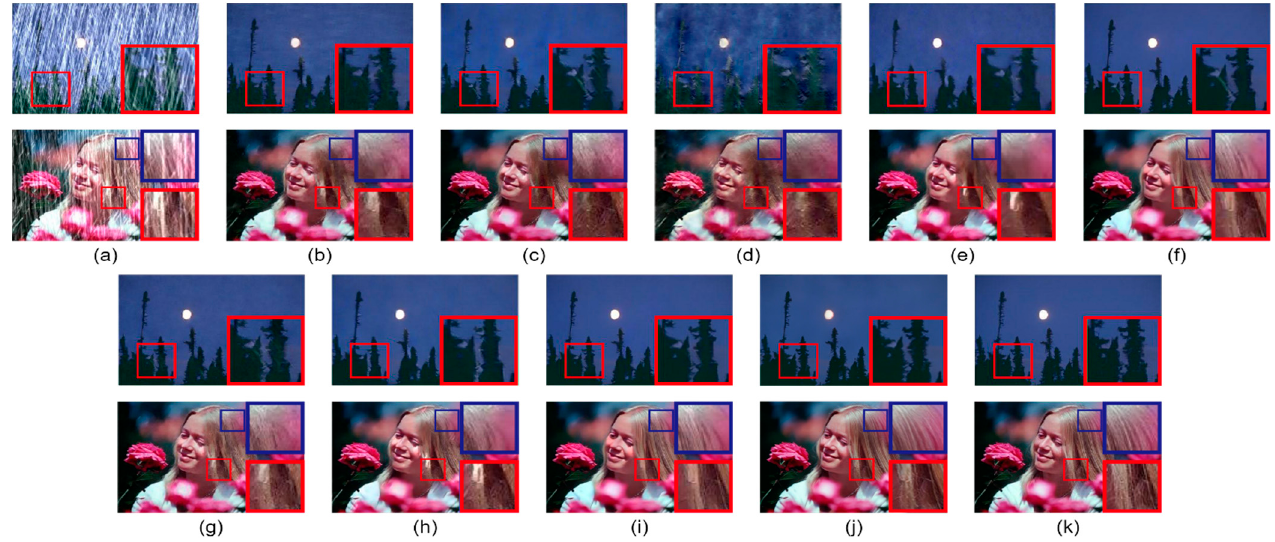
Figure 7. Deraining task performance of the proposed MARCAFNet and state-of-the-art methods when using the Rain100H dataset. ( a ) Rainy image, ( b ) RESCAN, ( c ) PReNet, ( d ) LPNet, ( e ) MSPFN, ( f ) MPRNet, ( g ) VRGNet, ( h ) PCNet, ( i ) RAiANet, and ( j ) MARCAFNet, and ( k ) ground